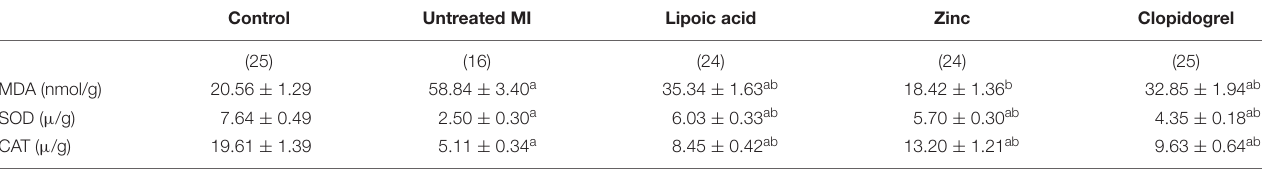
TABLE 7 | Cardiac tissue oxidative stress parameters of the control, untreated MI, and pre-treated MI groups. Control Untreated MI Lipoic acid